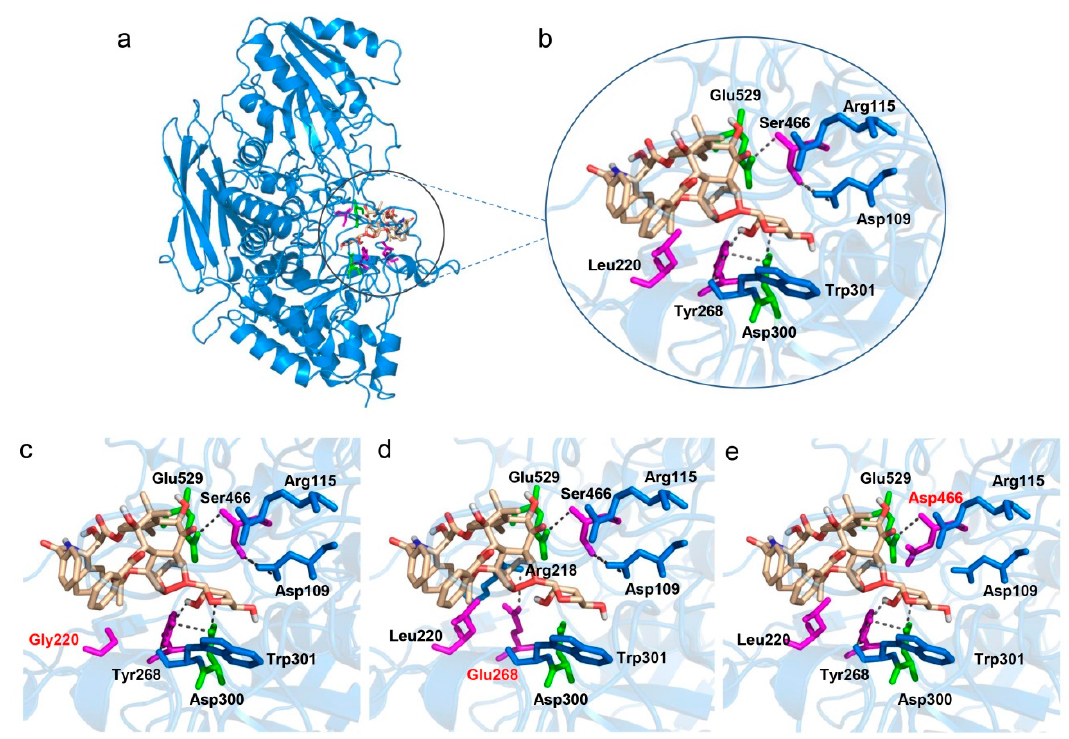
Figure 1. The 3D structure model of the protein–substrate complex. ( a ) Overview of LXYL-P1-2 in complex with XDT. Close-up view of molecular docking of LXYL-P1-2 ( b ) and mutants harboring L220G ( c ), T268E ( d ), and S466D ( e ) mutations with XDT. The carbon atoms of XDT are shown in wheat. The catalytic sites (Asp 300 and Glu 529 ) are shown in green. The residues (Leu 220 , Tyr 268 , and Ser 466 ) predicted to play important roles on enzyme activity are shown in magenta. The mutated sites are shown in red. Hydrogen bonds are shown as dotted lines.